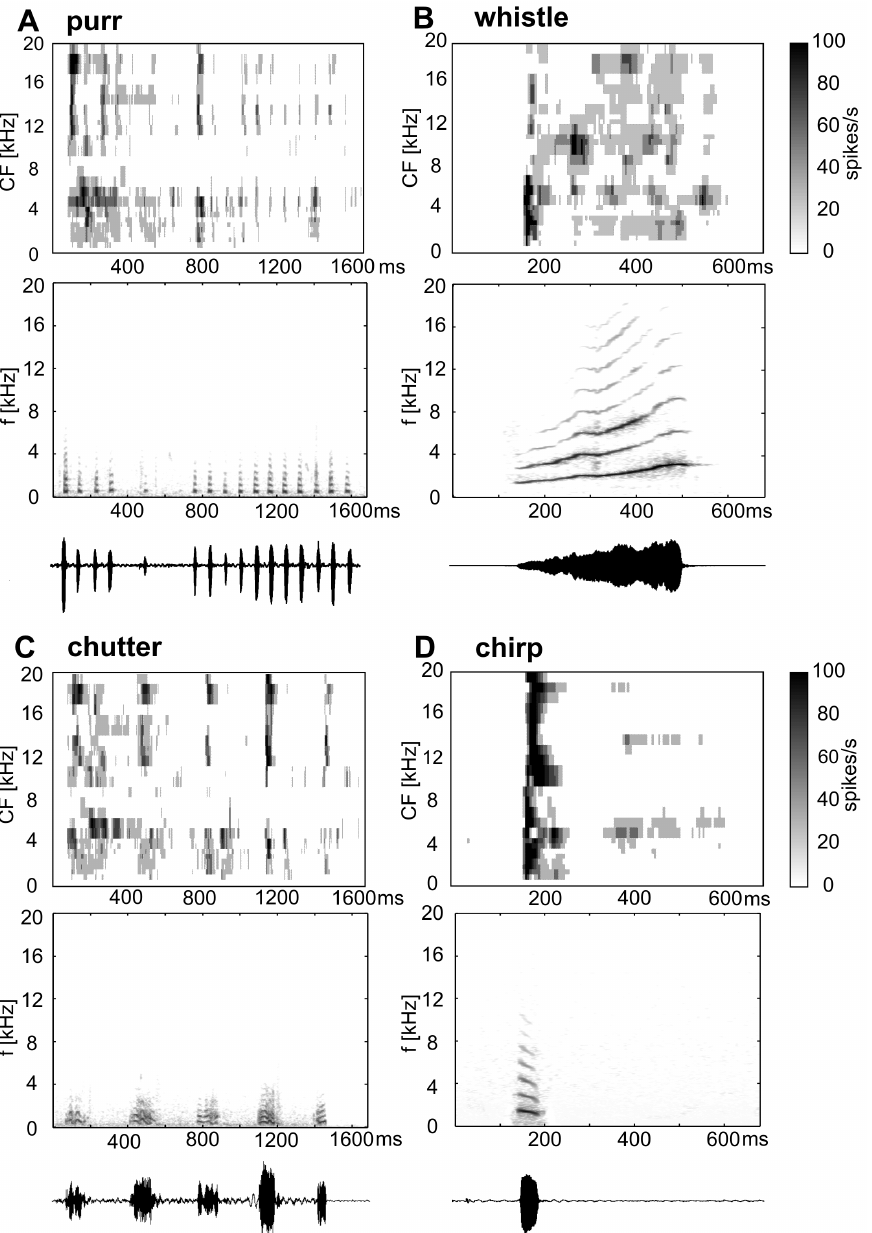
Figure 1. The spectrotemporal response maps of the neuronal population (n=502, top), the call spectrogram (middle) and the call waveform (bottom) are displayed for purr (A), whistle (B), chutter (C) and chirp (D).